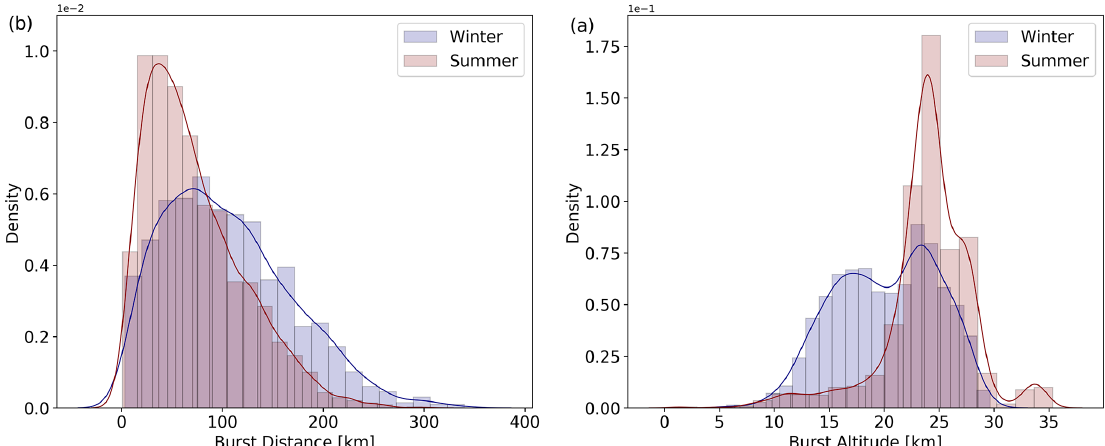
Figure A2. (a) Distribution of the distance between DDU and the burst location of DDU radiosondes in summer (red) and winter (blue) from 2010 to 2020. (b) Distribution of the burst height in summer (red) and winter (blue) from 2010 to 2020. Winter is defined as the period from June to September included, and Summer is the rest of the